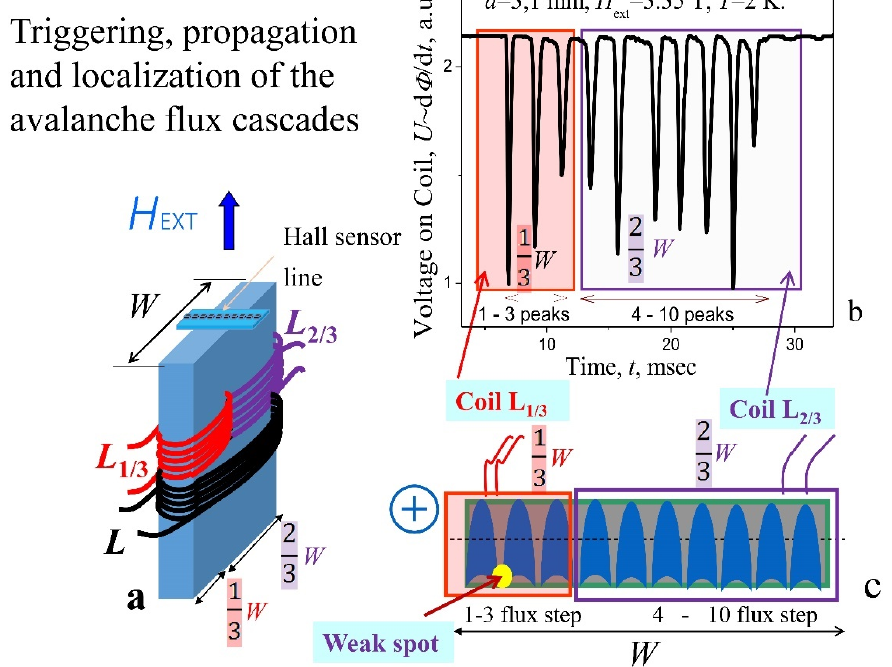
Figure 11. ( a ) The arrangement of pickup coils for the avalanche flux registration in the whole plate’s width ( W ) − ( L ), in the 1/3 W ( L 1/3 ) and in 2/3 W ( L 2/3 ); ( b ) one of the cascades recorded simultaneously by three coils L , L 1/3 , and L 2/3 ; d = 3.1 mm, H = 3.35 T, T = 2 K. Full signal registered by coil L is divided proportionally between the coils L 1/3 and L 2/3 , confirming spatial separation of impulses in cascades. ( c ) A schematic cross-section of a plate oriented orthogonally to magnetic field and spatial localization of successive flux avalanches. Weak spots appear in the concave corner, near the finger’s gate.